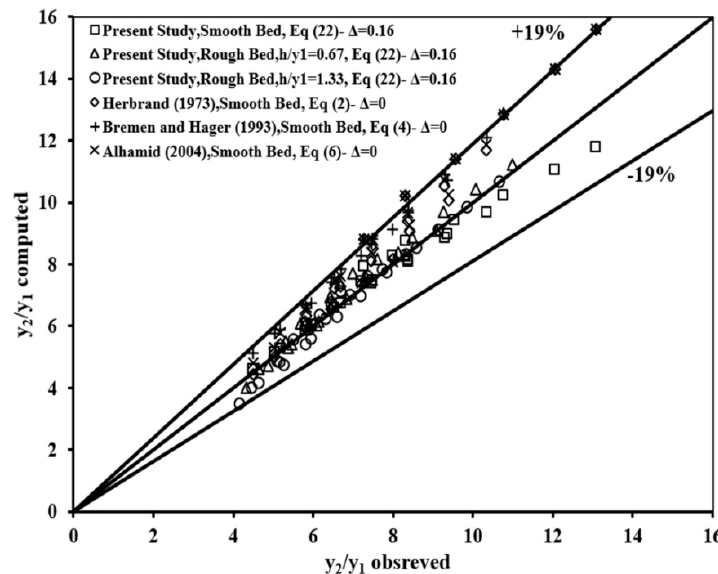
Figure 7. Comparison of the computed values of y 2 / y 1 by di ff erent prediction equations with the present observed data.